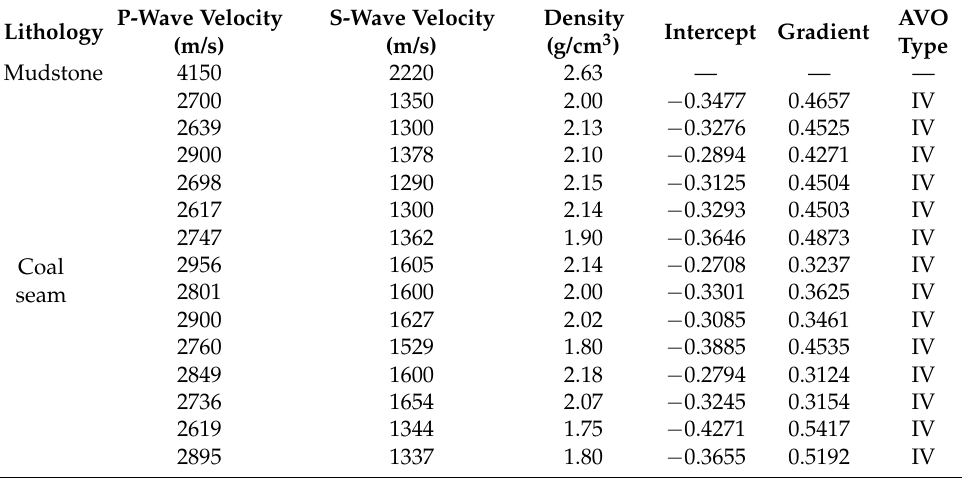
Table 2. Statistics concerning elastic parameters and AVO characteristics of drilled coal seams in the Pingbei slope